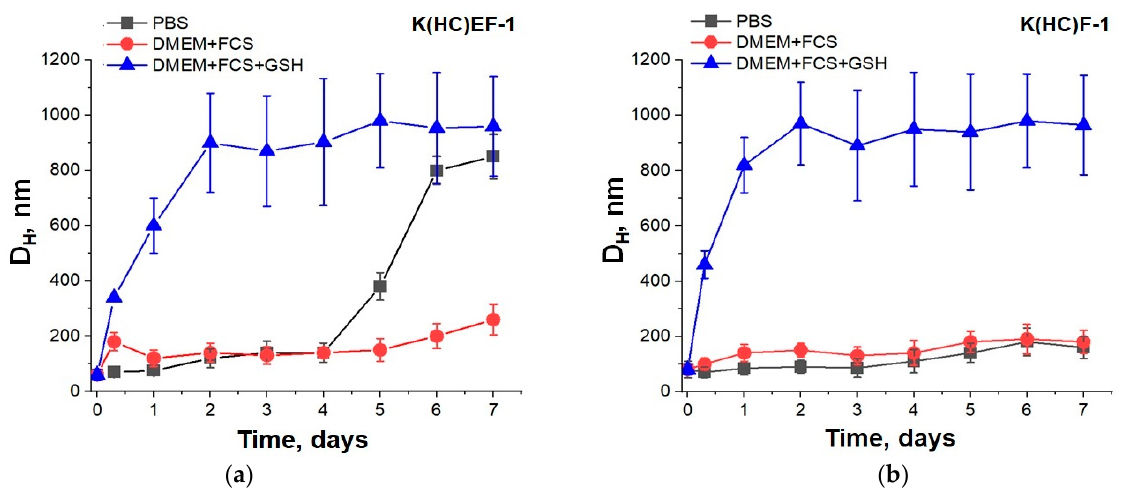
Figure 7. Stability of pDNA-loaded cross-linked nanoparticles based on K(HC)EF ( a ) and K(HC)F ( b ) polypeptides (incubation at 37 °C, DLS monitoring; polypeptide:pDNA ratio was equal to 20:1).